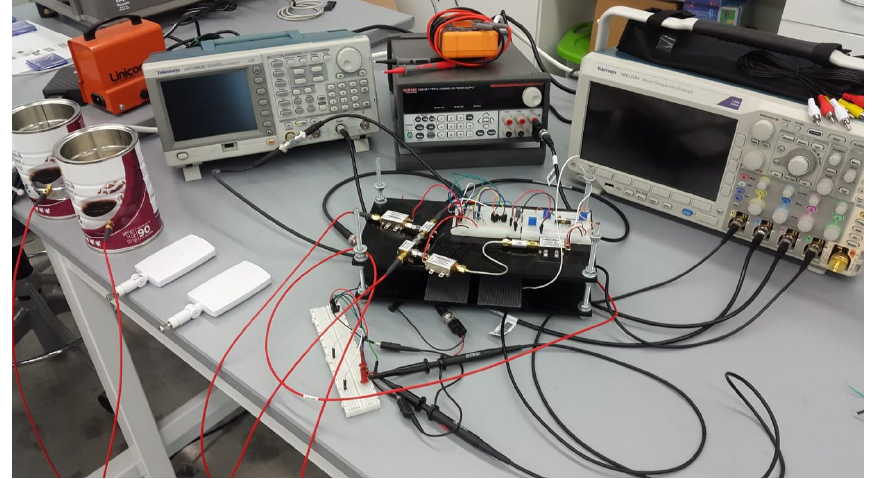
Figure 5. 2.4 GHz radar.